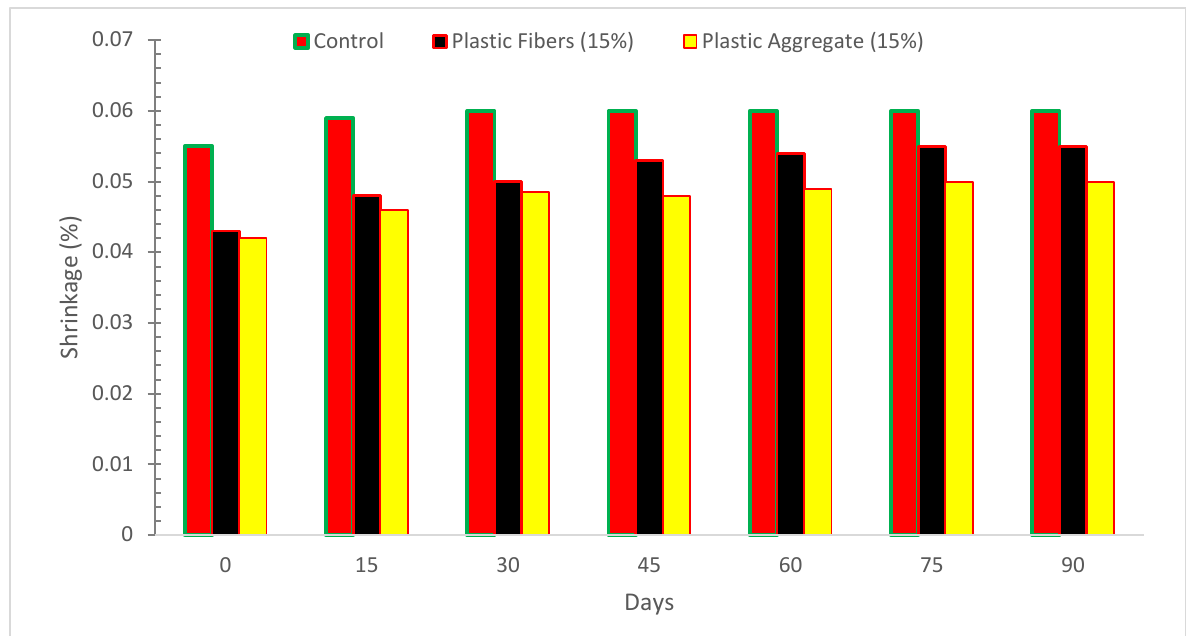
Figure 10. Shrinkage: Data Source [56].